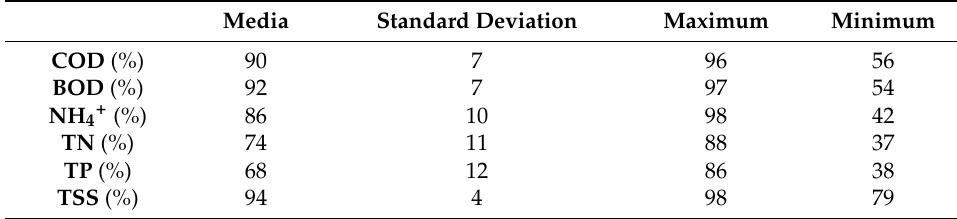
Table 2. Statistics of the removal efficiencies for the whole set of plants